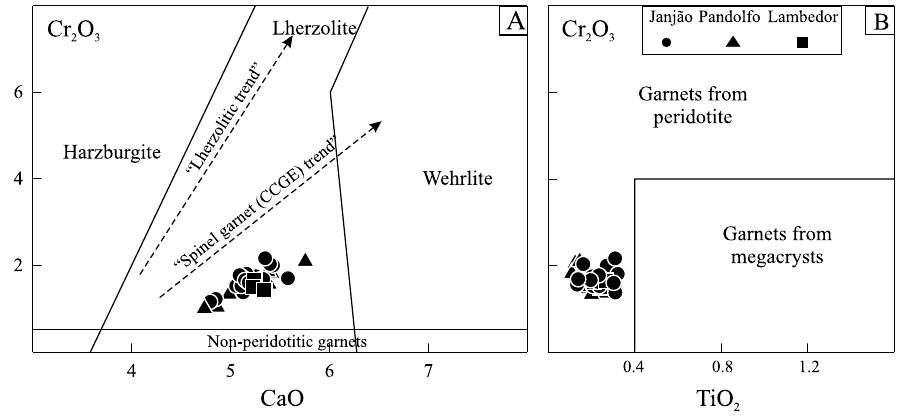
Fig. 6 – A) Variation of CaO vs. Cr 2 O 3 for garnets from the Janjão and Pandolfo diatremes. Boundaries between harzburgitic, lherzolitic and non-peridotitic garnets and between lherzolitic and wehrlitic domains are from Gurney and Zweistra (1995) and from Sobolev et al. (1973), respectively. Spinel garnet (CCGE) trend is after Kopylova et al. (2000). B) Variation of Cr 2 O 3 vs. TiO 2 for garnets from the Janjão, Pandolfo and Lambedor diatremes. Boundary between peridotitic and megacrystic domains are from Schulze (2003).